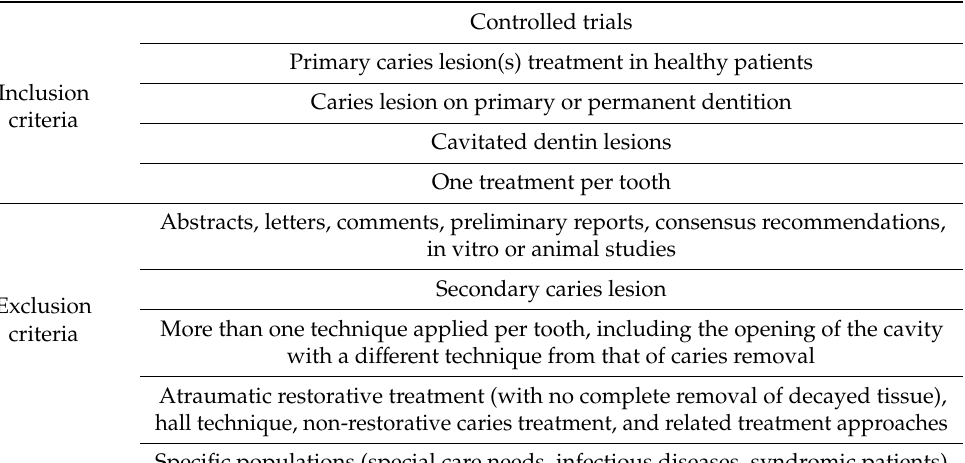
Table 2. Inclusion and exclusion